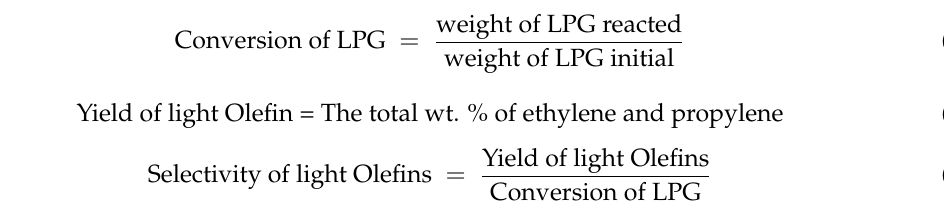
Figure S1: Effect of temperature on oxidative dehydrogenation of LPG for 4 wt. % FeHZSM-5, 4 wt. % CuHZSM-5 and 4 wt. % ZnHZSM-5 catalysts on selectivity in presence and absence of electric field: on olefin selectivity: 100 mg catalyst, 6 mA, 10 mm gap distance and 4 wt. % metal loading, Figure S2: Effect of gap distance on oxidative dehydrogenation for 4 wt. % FeHZSM-5, 4 wt. % CuHZSM-5 and 4 wt. % ZnHZSM-5 catalysts on olefin selectivity: 100 mg catalyst, 625 ◦ C, 6 mA, and 4 wt. % metal loading, Figure S3: Effect of metal loading on oxidative dehydrogenation for 4 wt. % FeHZSM-5, 4 wt. % CuHZSM-5 and 4 wt. % ZnHZSM-5 catalysts on olefin selectivity: 100 mg catalyst, 625 ◦ C, 6 mA, and 10 mm gap distance, Figure S4: Band gap, potentials of valence and conduction bands of various semiconductor metal oxides, Figure S5: The schematic of fixed bed flow type reactor in the electric